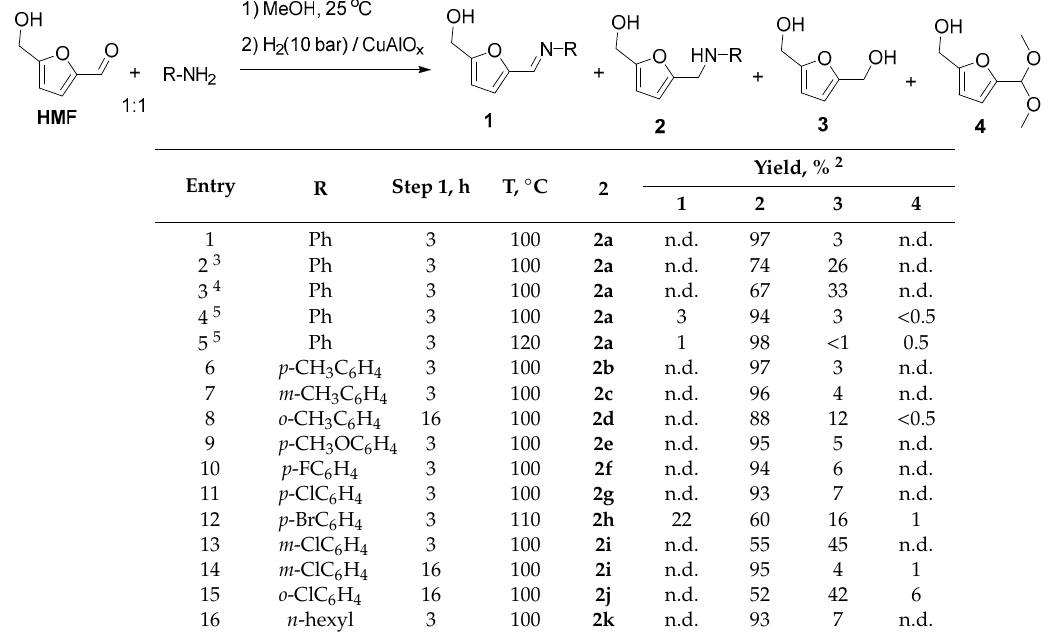
Table 2. Two-step one-pot reductive amination of HMF with primary amines 1 .